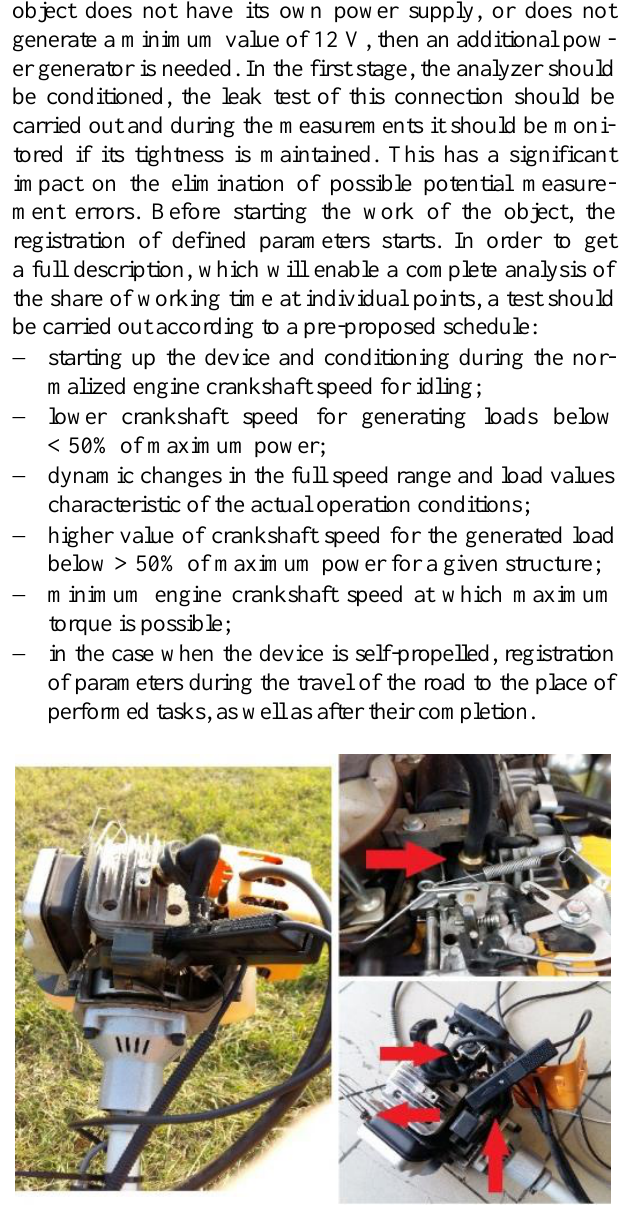
Fig. 5. Measuring elements during installation in a mobile